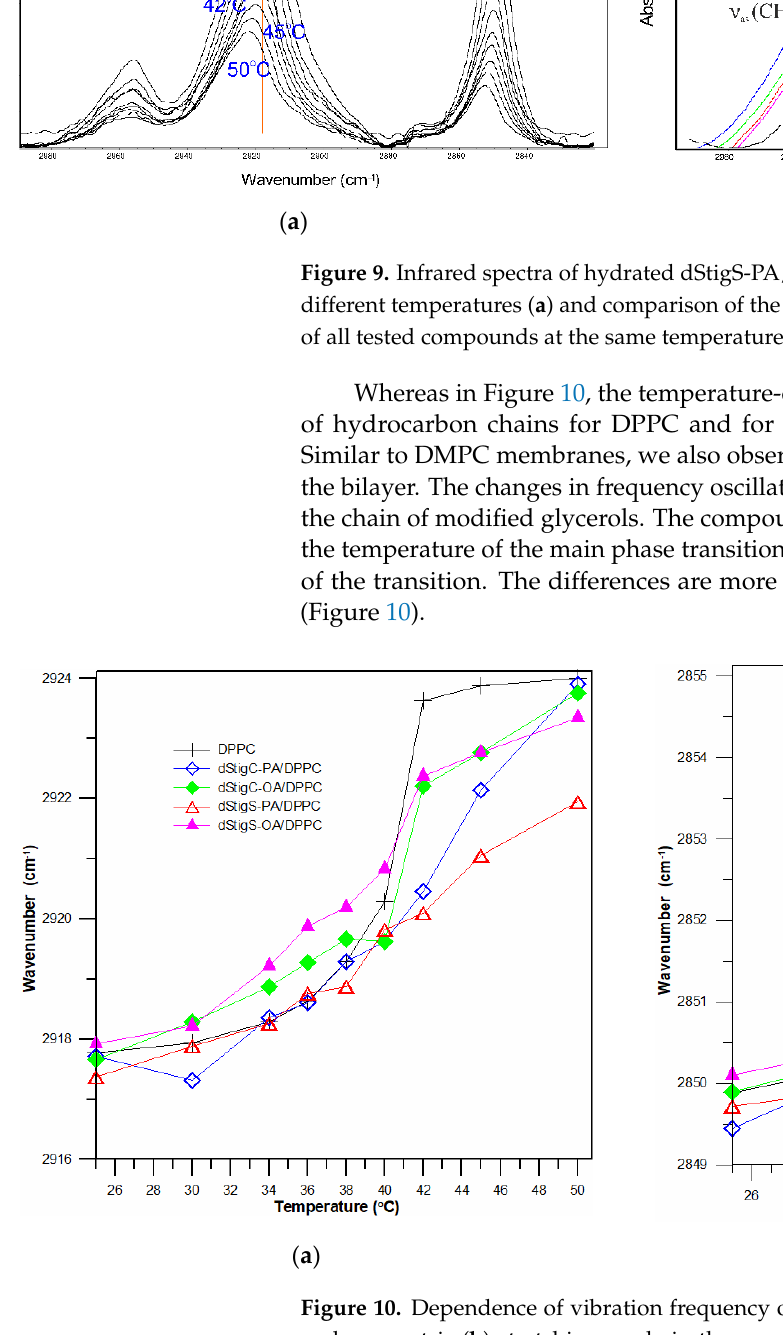
Figure 10. Dependence of vibration frequency on system temperature of the CH 2 asymmetric ( a ) and symmetric ( b ) stretching mode in the presence and absence of dStigMAs for DPPC bilayer; n dStigMAs /n DPPC = 0.20.